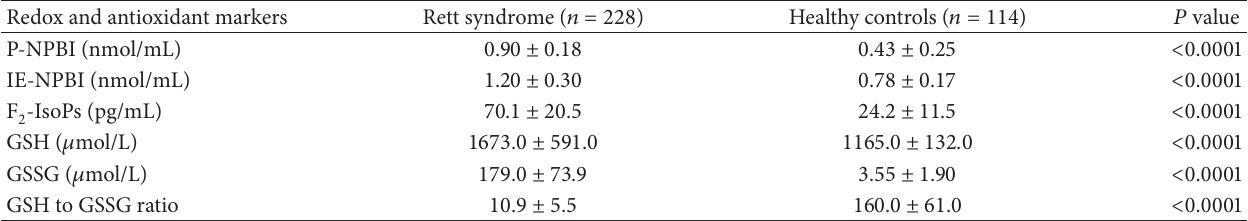
Table 3: Redox/antioxidant status in patients with typical Rett syndrome: systemic oxidative stress with decreased GSH/GSSG ratio. Redox and antioxidant markers